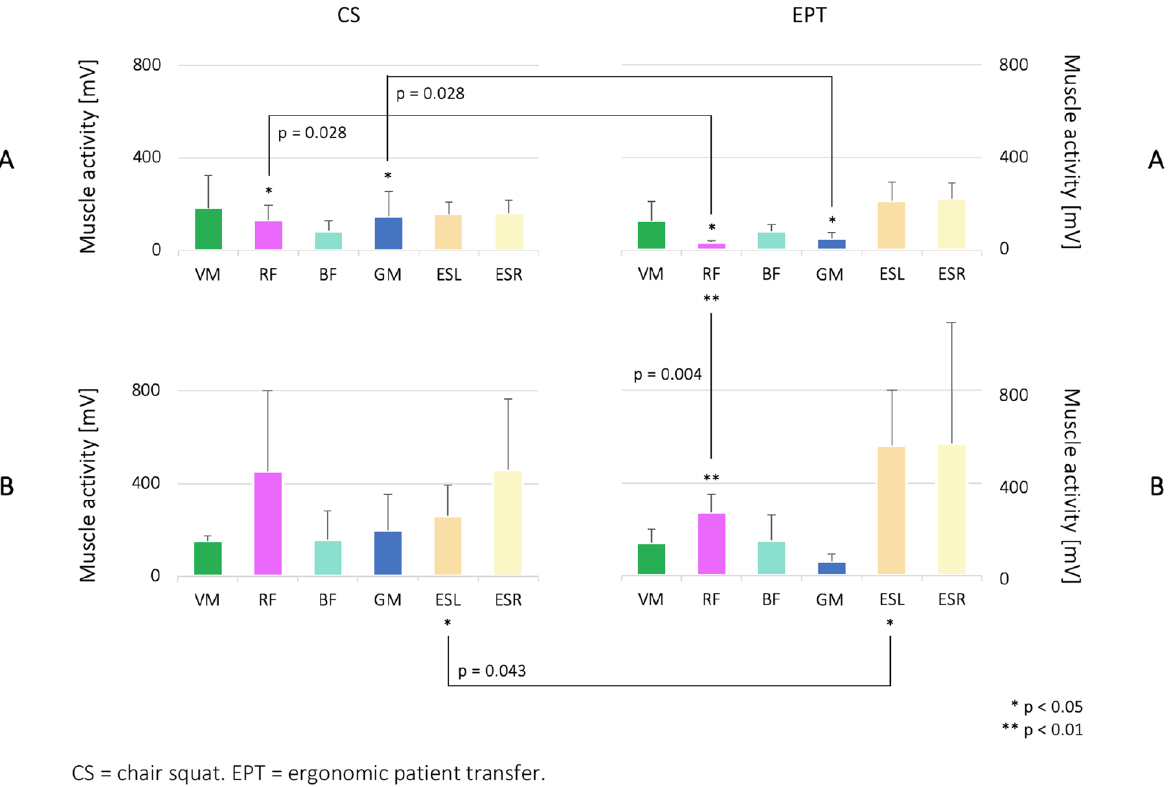
Figure 5. RMS muscle activity data of vastus medialis (VM), rectus femoris (RF), biceps femoris (BF), gluteus maximus (GM), left erector spinae (ESL), and right erector spinae (ESR). The results are presented as means ± standard deviations, including significant comparisons of each group’s two-sided Wilcoxon signed-rank test (Supplementary Material, Table 5). Significant results of the Mann–Whitney test for inter-group comparison are presented in Supplementary Material, Table